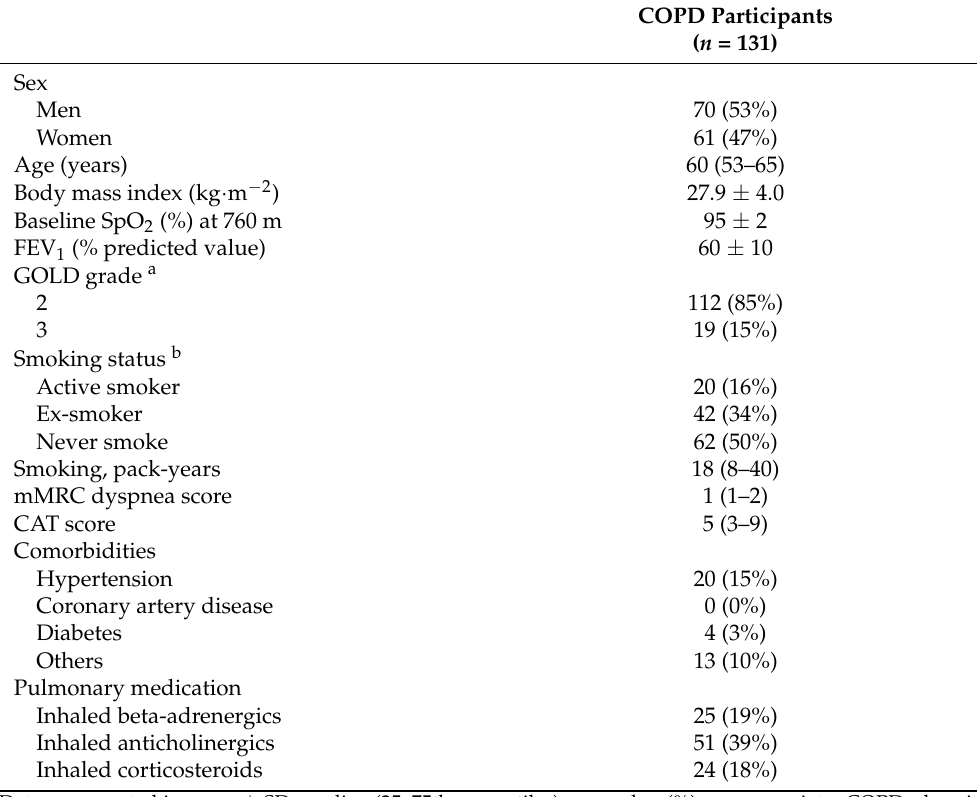
Table 1. Participant characteristics.